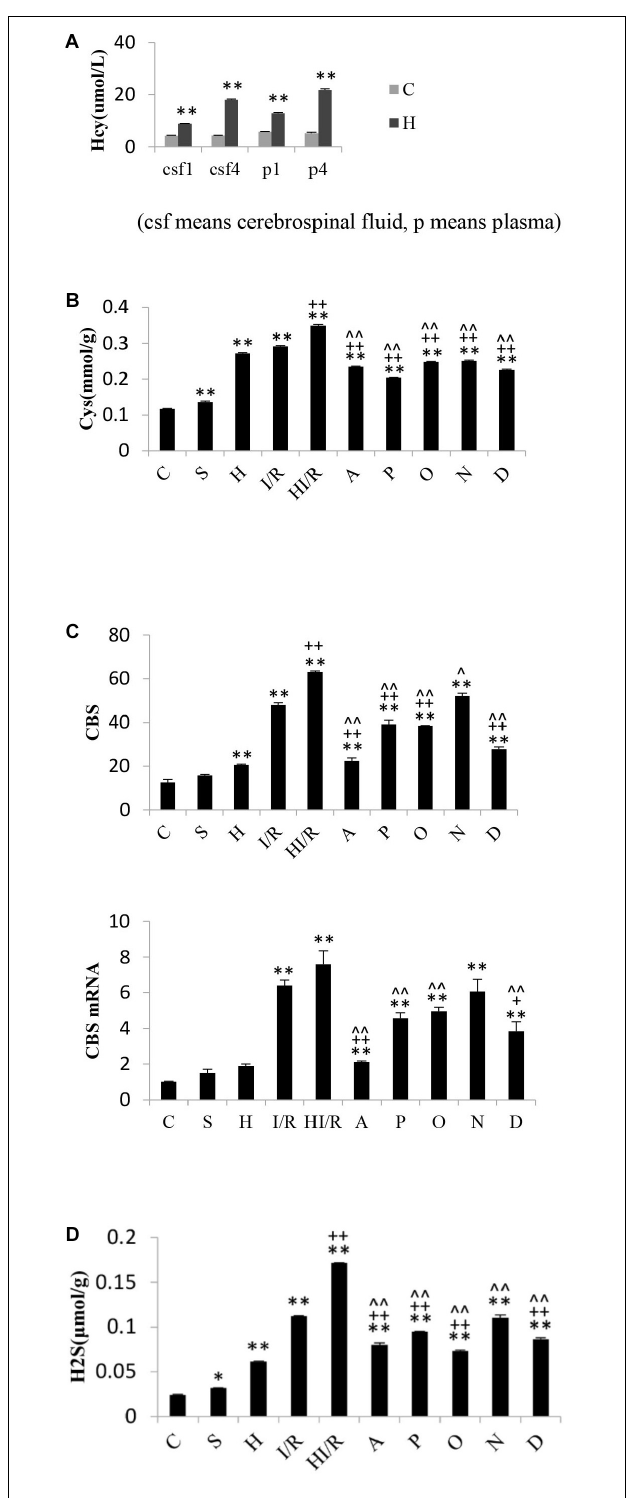
FIGURE 6 | Changes of Hcy levels in rats fed for one and 4 weeks, and Cys, CBS, and H 2 S levels in rats 24 h after I/R or not. (A) Hcy levels in plasma and cerebrospinal fluid of rats received normal food or food added methionine for 1 week or 4 weeks. A higher Hcy level appeared in H group than that in